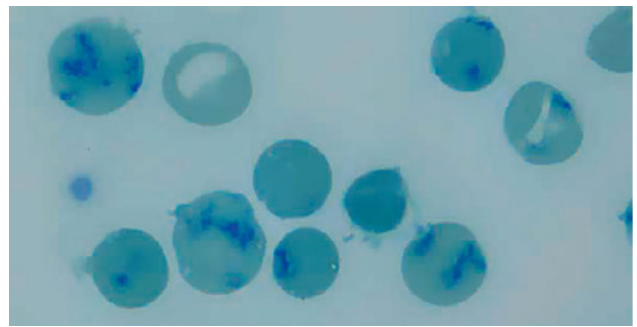
Figure 2 HPLC pattern of our patient with Hb